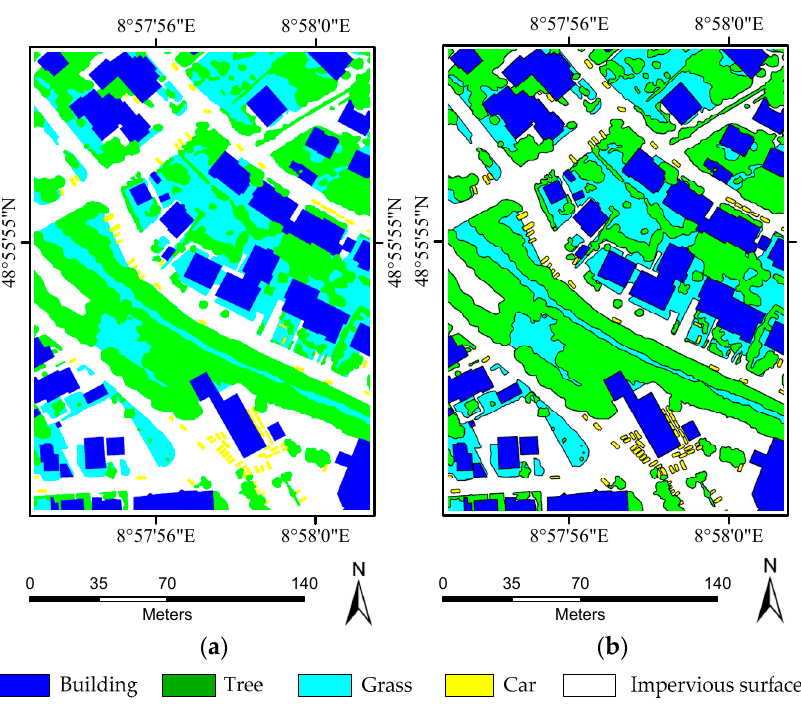
Figure 10. Ground truth data used for the training and evaluation: ( a ) “full reference” ground truth; ( b ) “no boundary” ground truth, the black areas in this reference will be ignored during evaluation.